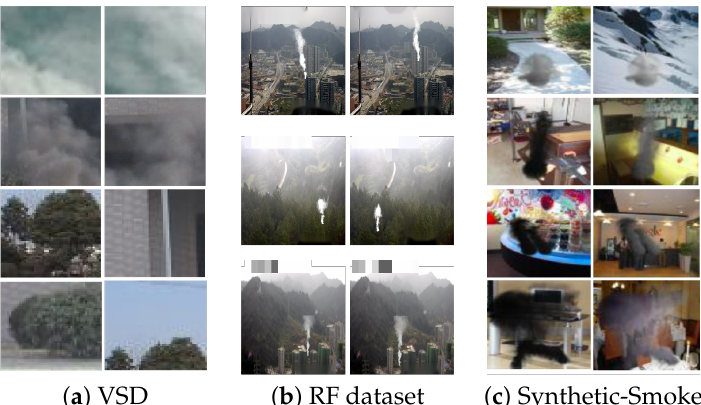
Figure 3. Some samples from existing